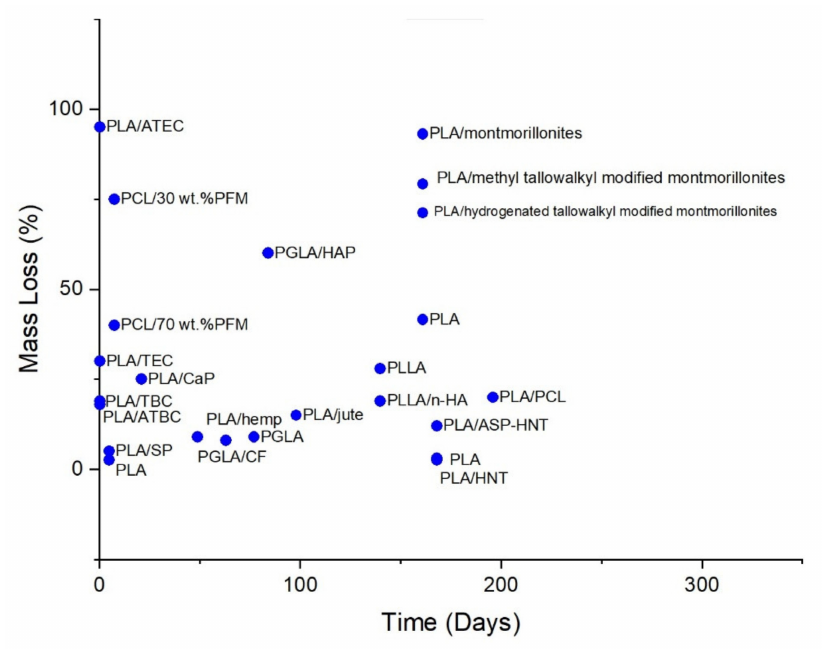
Figure 8. Mass Loss percentage of composites in various hydrolytic degradation